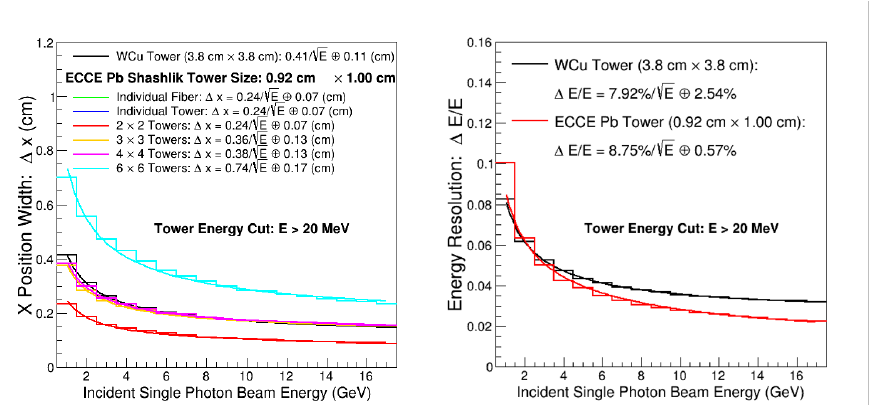
Figure 1. The position resolution of the WCu and ECCE EMCALs with di ff erent readout schemes (left) and the energy resolution of the WCu and ECCE EMCALs as well as their fits to the function y = a / √ E b are shown above. Individual fiber (green), individual tower (blue), and 2 2 towers (red) ⊕ × are overlapping with each other and only the 2 2 towers data points are seen. ×